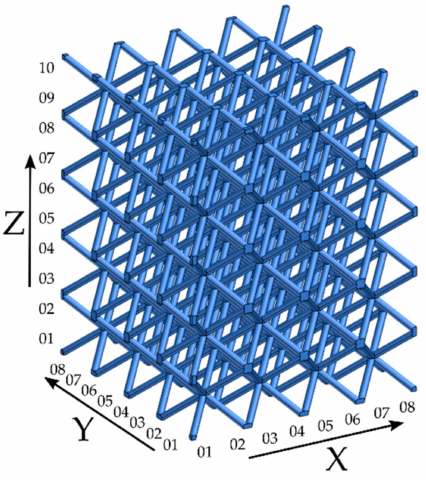
Figure 7. Numbering convention used in all